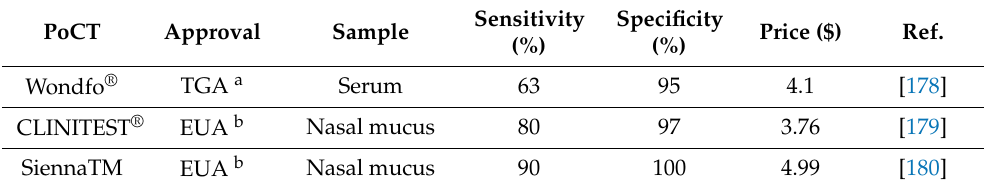
Table 2. Comparison of some approved COVID-19 rapid antigen